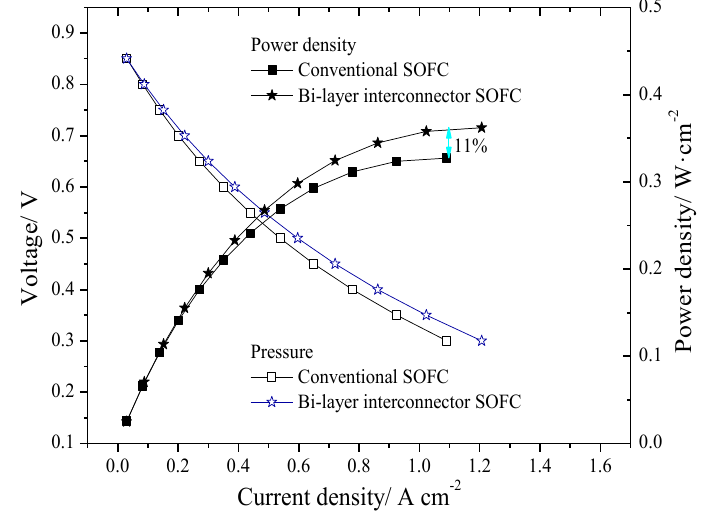
Figure 5. The electrical properties of steady state models with different